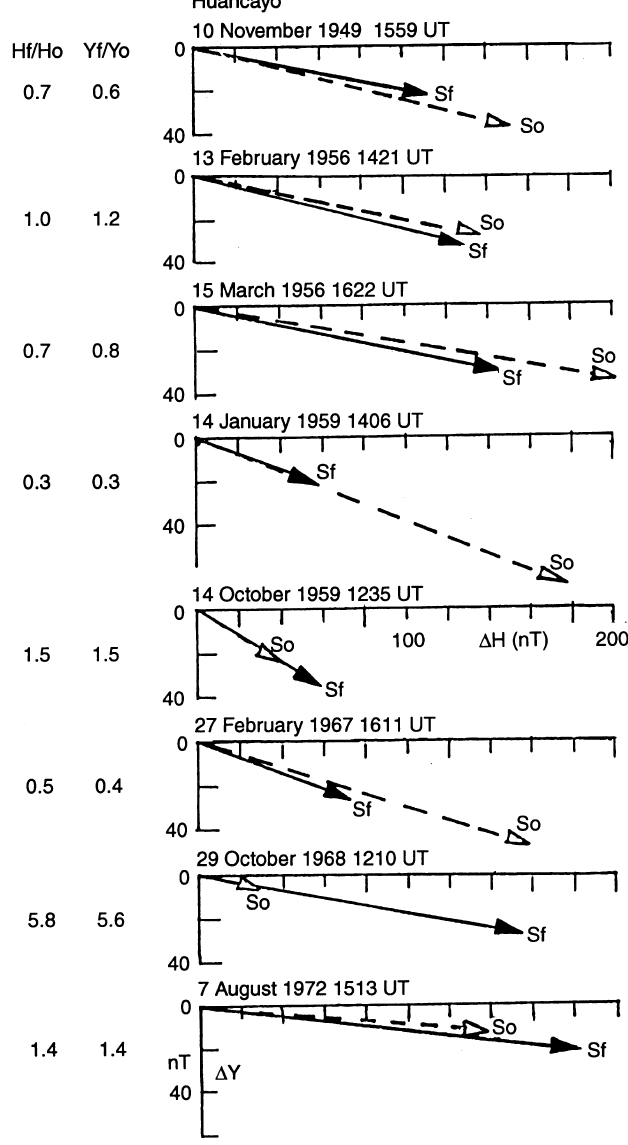
Fig. 12. Current vectors due to solar flare and pre flare Sq fields at Huancayo during some of the